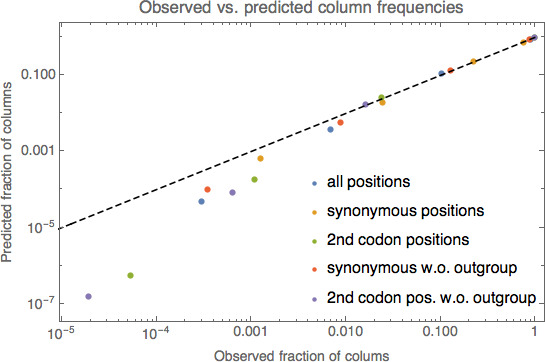
Comparison of the observed frequencies of columns with different numbers of nucleotides with predictions from a simple substitution model.Comparison of the observed frequencies of columns with 1, 2, 3, and 4 different nucleotides under the simple model described in the methods. Different colored dots correspond to different subsets of columns, as indicated in the legend. For each color, four dots are shown corresponding to the observed frequencies of columns with 1, 2, 3, and 4 nucleotides (horizontal axis) and the predicted frequencies according to the simple model (vertical axis). The dashed line shows the identity y=x. Both axes are shown on logarithmic scales.